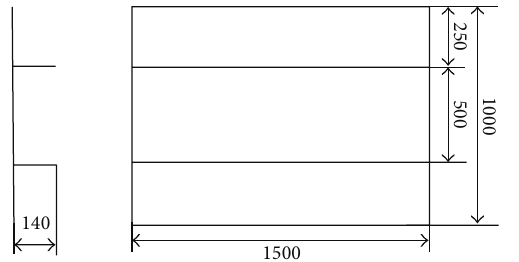
Figure 9: Dimensions of the panel structure.